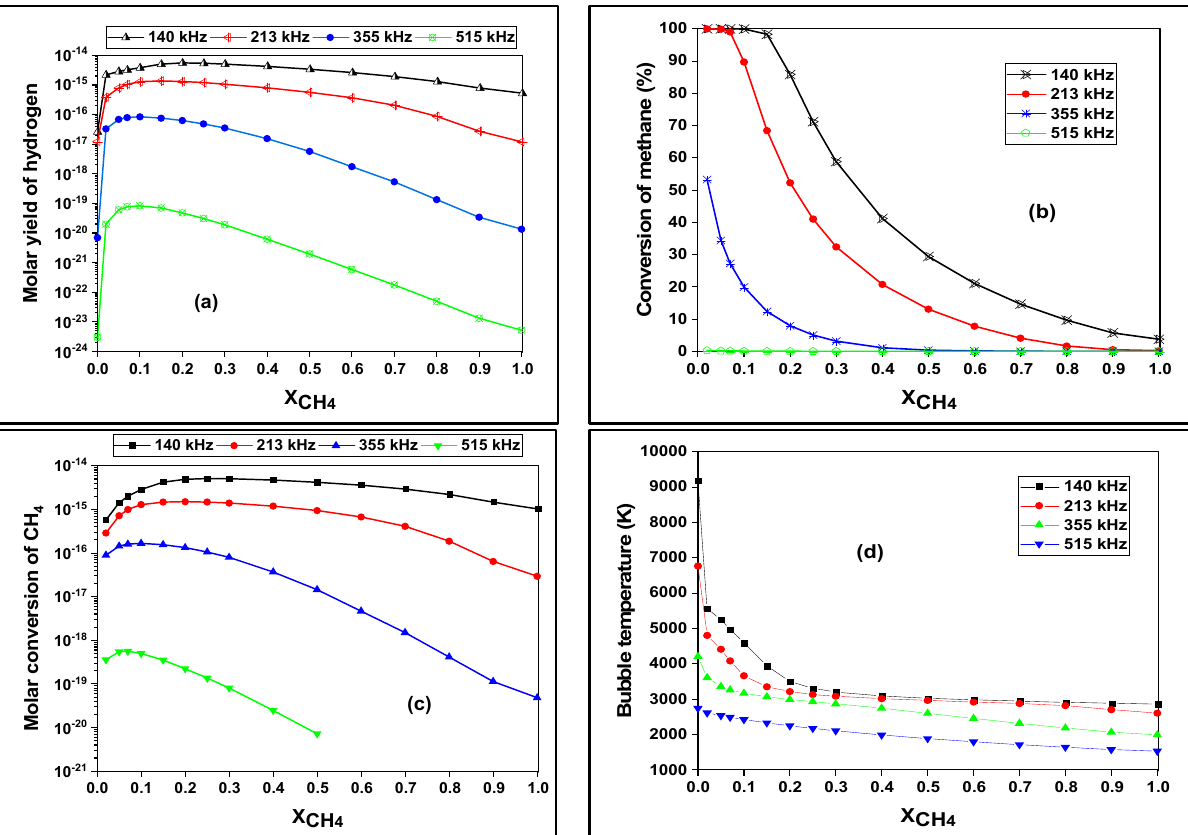
Figure 3. Effect of initial methane mole fraction (inside the bubble) and ultrasound frequency (140–515 kHz) on: ( a ) the molar evolution of hydrogen; ( b ) methane conversion (%); ( c ) molar conversion of CH4; and ( d ) the variation in bubble temperature (K).